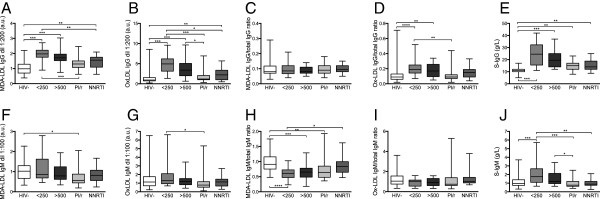
Concentrations of total and oxidized forms of IgM and IgG in HIV- controls and the different HIV + groups. Figure shows HIV-negative controls (HIV-), untreated HIV + subjects with CD4 < 250 (< 250) or > 500 (> 500), and HIV + treated subjects on a boosted protease inhibitor regimen (PI/r) or an NNRTI regimen (NNRTI). A. MDA-LDL IgG, B. OxLDL IgG, C. Ratio MDA-LDL IgG/total IgG, D. Ratio OxLDL IgG/total IgG, E. Total IgG, F. MDA-LDL IgM, G. OxLDL IgM, H. Ratio MDA-LDL IgM/total IgM, I. Ratio OxLDL IgM/total IgM, J. Total IgM. Boxes encompass interquartile ranges with median (line), whiskers designate the range. *p < 0.05, **p < 0.01, ***p < 0.001, a.u.: arbitrary units.